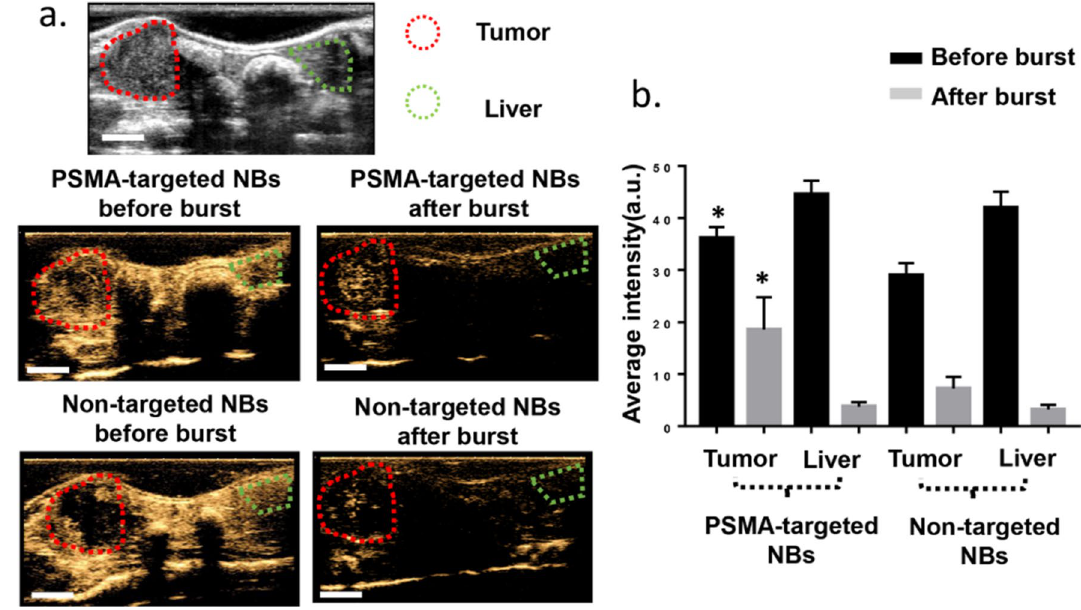
Figure 5. PSMA-targeted NBs enable prolonged imaging and greater US signal in PSMA-positive PC3pip tumors after removing nanobubbles from the circulation. ( a ) The first row showed the B-mode image of the tumor and liver before injection. The second row showed the CHI of the tumor and liver before bubble burst. The third row showed the CHI of the tumor and liver after bubble burst. Scale bar is 0.5 cm. ( b ) The average signal intensities of bubbles in the tumor and liver before and after burst. Data are presented as mean ± standard deviation, * p < 0.05, targeted group vs. non-targeted group, n =